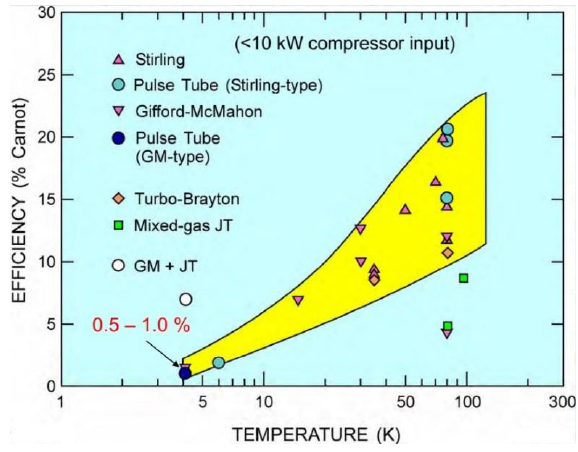
Figure 8. Efficiency of small cryocoolers < 10 kW